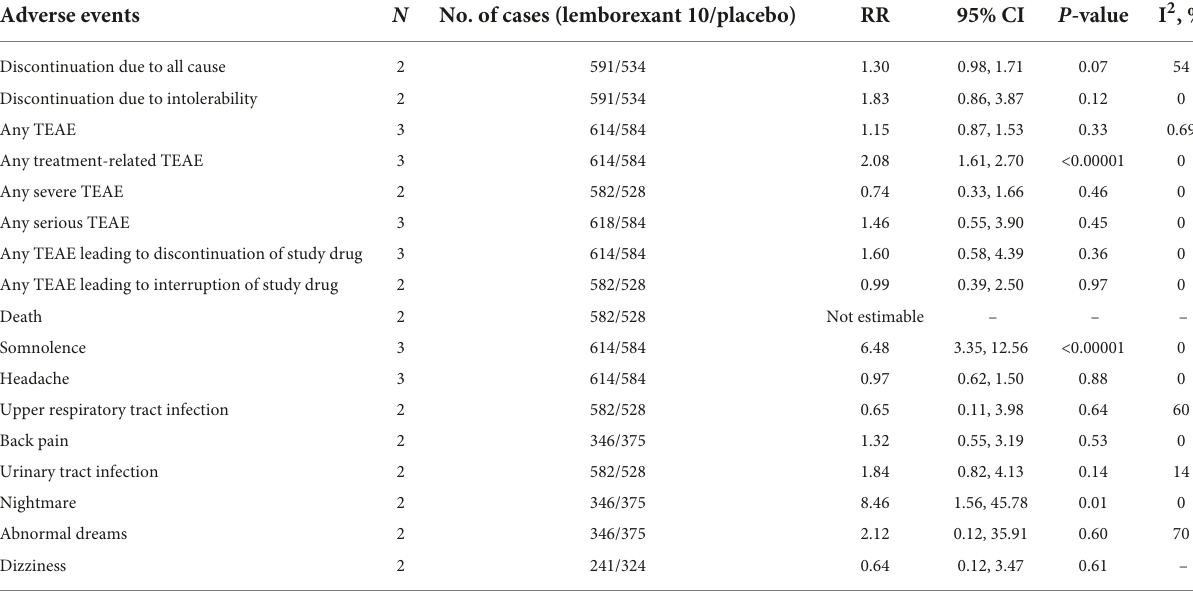
TABLE 8 Treatment discontinuation and individual adverse events for lemborexant 10 vs. placebo. Adverse events N No. of cases (lemborexant 10/placebo) RR 95% CI P -value I 2 , %